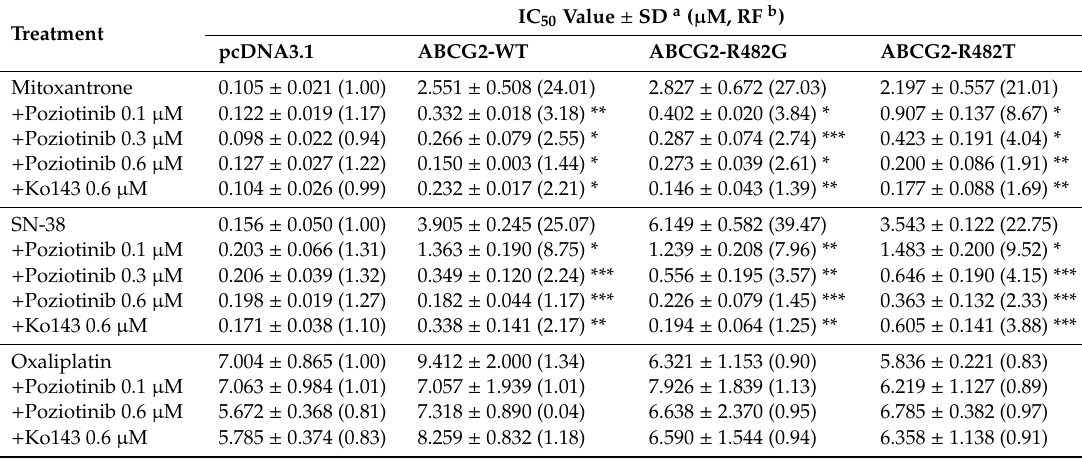
Table 3. The e ff ect of poziotinib and Ko143 on the e ffi cacy of mitoxantrone, SN-38 and oxaliplatin in ABCG2 gene-transfected HEK293 cells overexpressing the ABCG2 transporter.